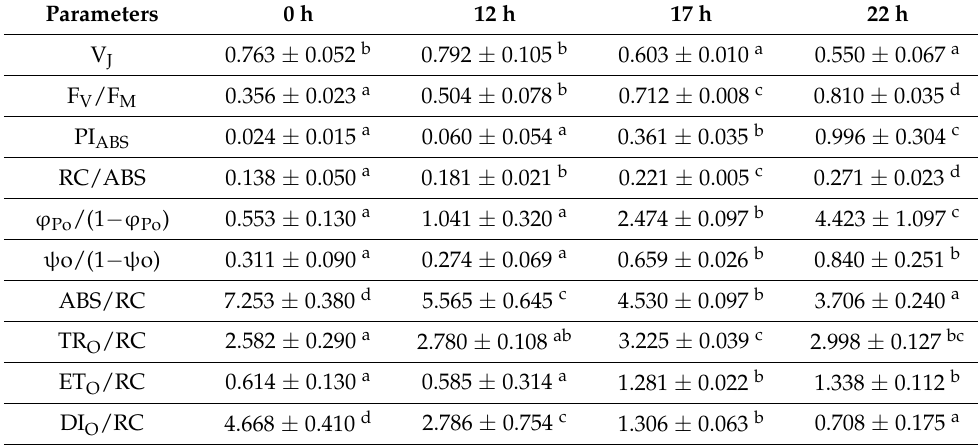
Table 2. Statistical comparison of parameters obtained from the JIP-test of four samples. Parameters 0